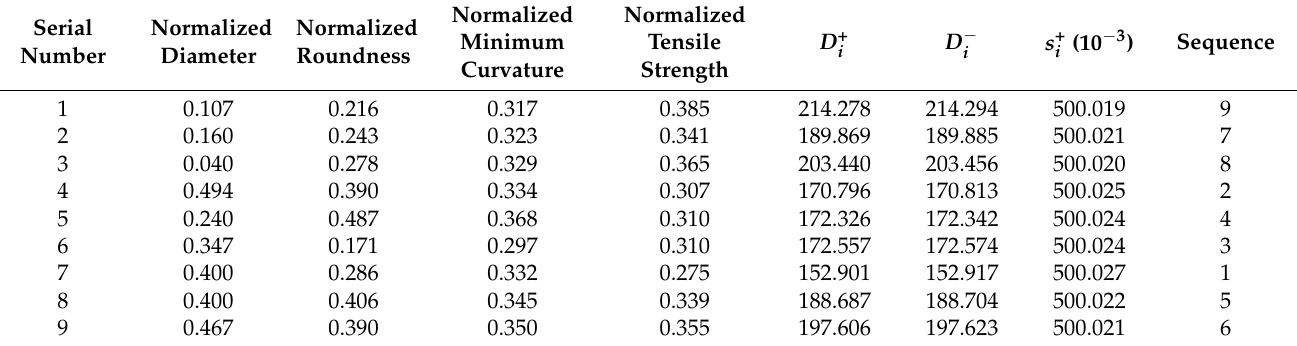
Table 9. Relative proximity under the weight coefficient scheme of the entropy weight method.